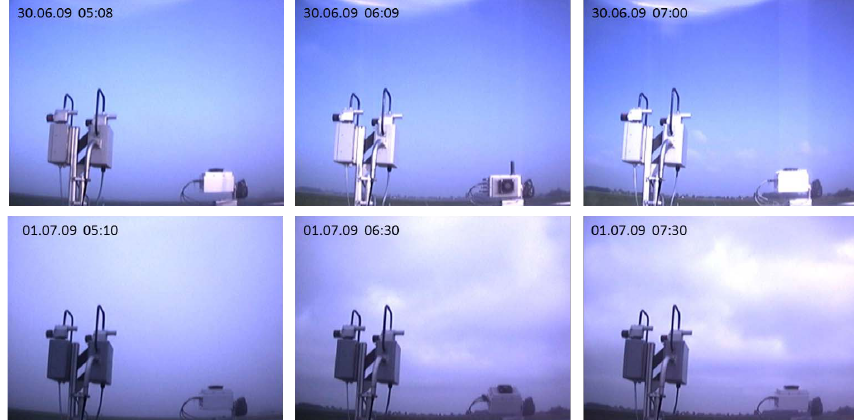
Figure 8. Webcam images from the mornings of 30 June and 1 July 2009, when foggy conditions prevailed. The webcam pointed to the viewing direction of the MAX-DOAS Instruments (north-east). The devices in the foreground are the telescopes of the Heidelberg group.